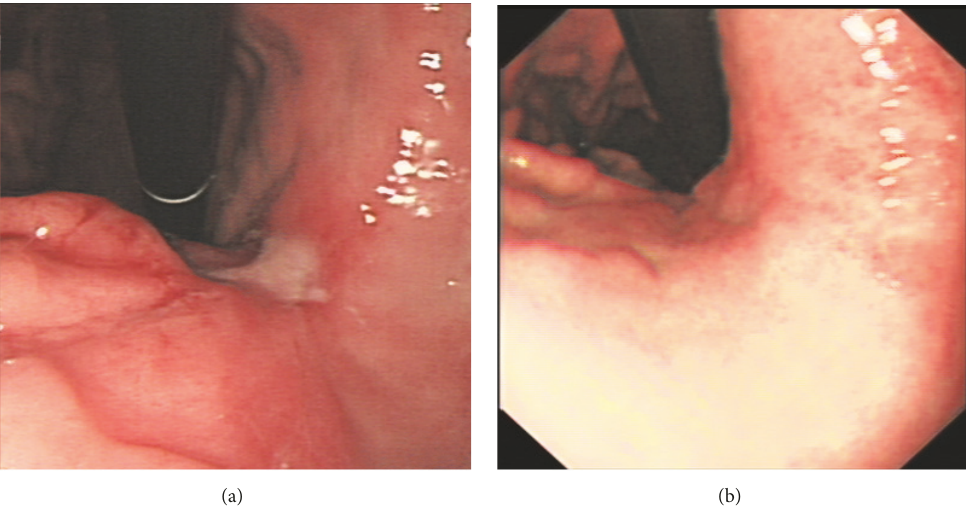
Figure 1: Initial (a) and follow-up (b) endoscopic findings after six cycles of EOX chemotherapy . (a) A large ulceroinfiltrative mass at the anterior wall of the lesser antral curvature, covered with whitish fur, and no apparent active bleeding; (b) ulcer lesion disappeared and replaced by scar.